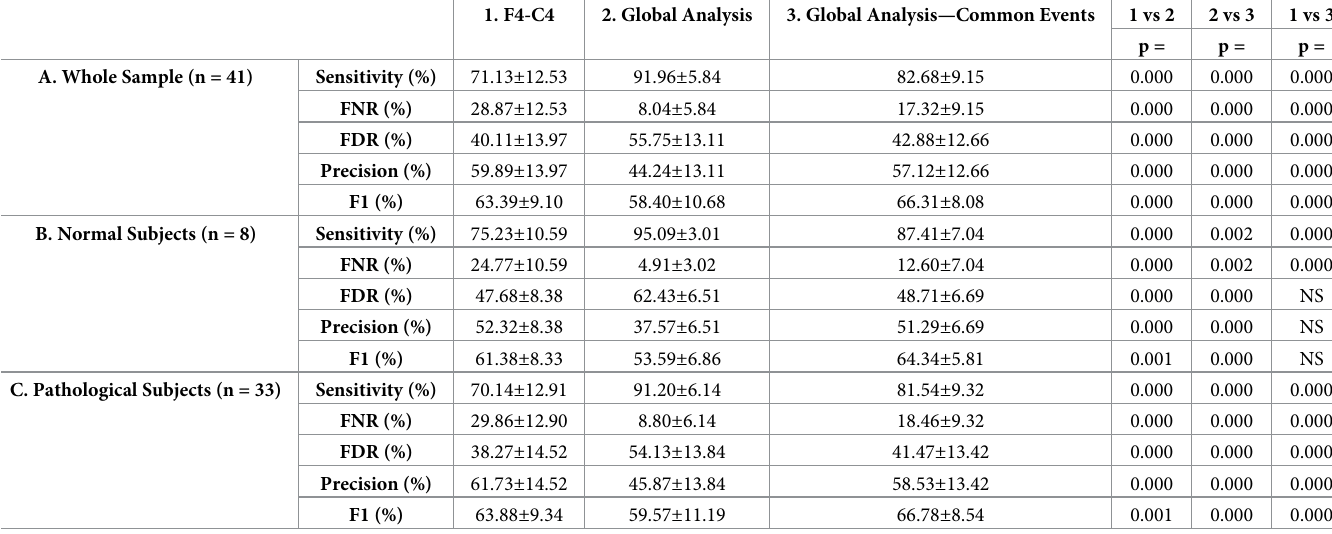
Table 4. Performance metrics: Local and multi-trace algorithms.